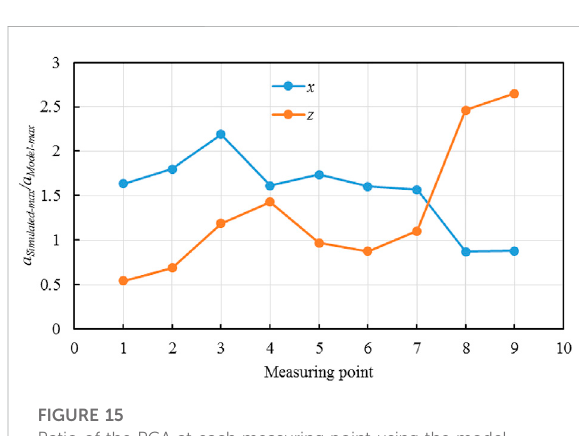
FIGURE 15 Ratio of the PGA at each measuring point using the model test and numerical simulation of the loess